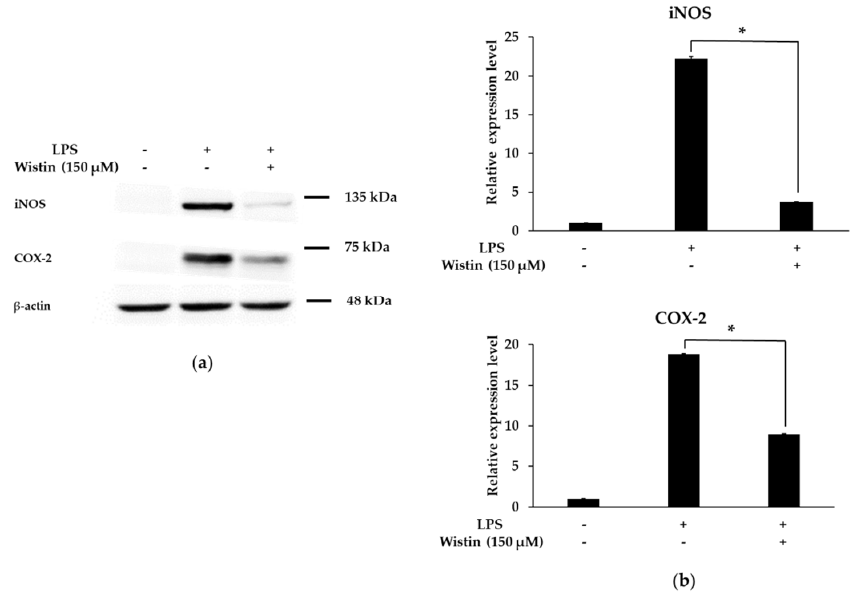
Figure 4. The effects of wistin on protein expression of iNOS and COX-2 in LPS-induced RAW 264.7 cells. The cells were treated with the indicated concentrations of wistin for 30 min prior to treatment with LPS (0.1 µ g/mL) for 24 h. ( a ) The protein levels of pro-inflammatory enzymes iNOS and COX-2 were determined by Western blot. ( b ) Quantitative analysis of the iNOS/ β -actin and COX-2/β- actin using image J. * p < 0.05 compared with the LPS-treated group. The data are presented as the means ± SD; n = 2.